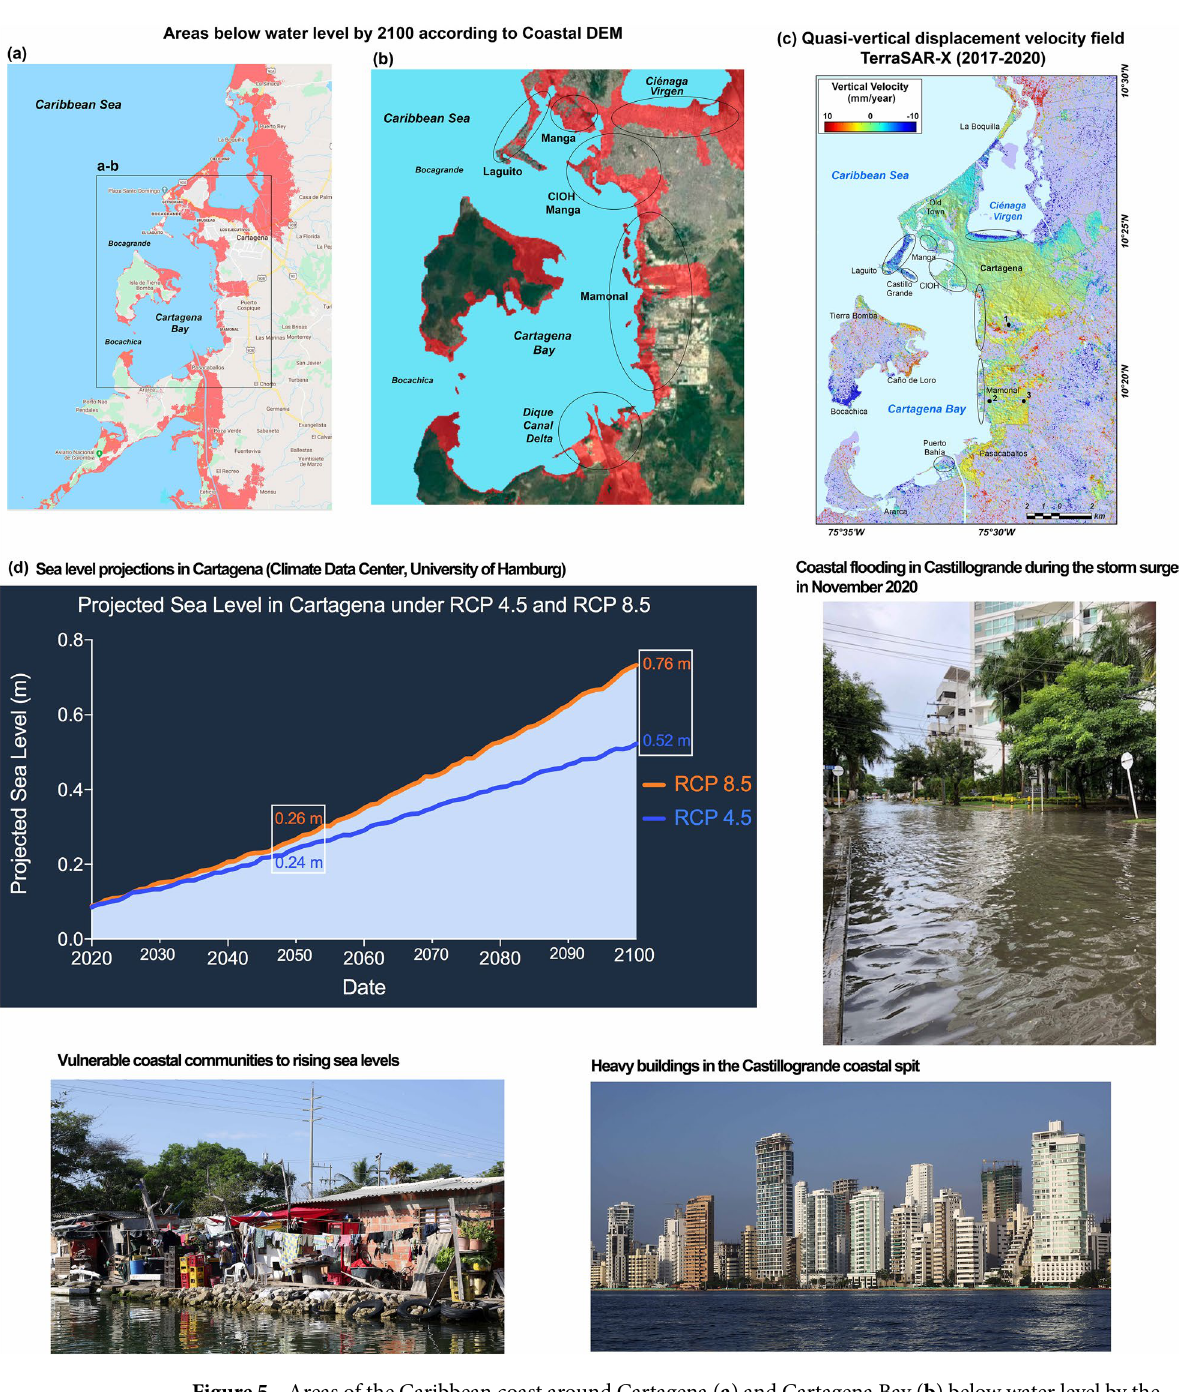
Figure 5. Areas of the Caribbean coast around Cartagena ( a ) and Cartagena Bay ( b ) below water level by the year 2100 based on a new digital elevation model, Coastal DEM, produced by Climate Central 32,44 (DEMS from open source at https:// clima tecen tral. org/ pdfs/ 2019C oasta lDEMR eport ). ( c ) TerraSAR-X image of quasi- vertical displacements (mm/yr) in Cartagena during the 2017–2020 period (InSAR map generated by open- source Python 3.8 using matplotlib module version 3.4.1). Mud volcanoes El Rodeo (1), Membrillal (2), and Turbaco (3) are also shown. Most of current subsiding lands ( c ) coincide with projected flooded areas by 2100 ( b ). ( d ) Sea level projections in Cartagena by 2050 and 2100 obtained from the Integrated Climate Data Center of the University of Hamburg (ICDC, http:// icdc. cen. uni- hambu rg. de/1/ daten/ ocean/ ar5- slr. html) ( Photo credits of Cartagena – Juan D. Restrepo, IDRC-BASIC Project)